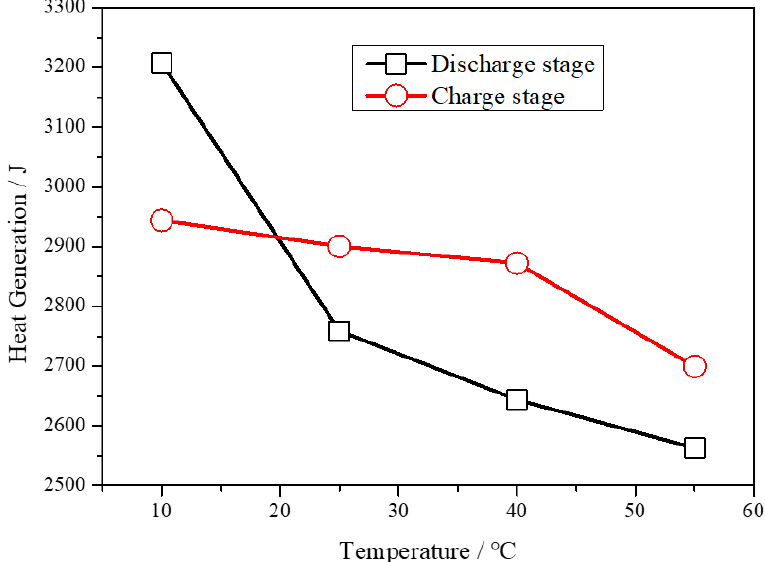
Figure 8. Heat generation curve changing with temperature under the operating current of 2 A.